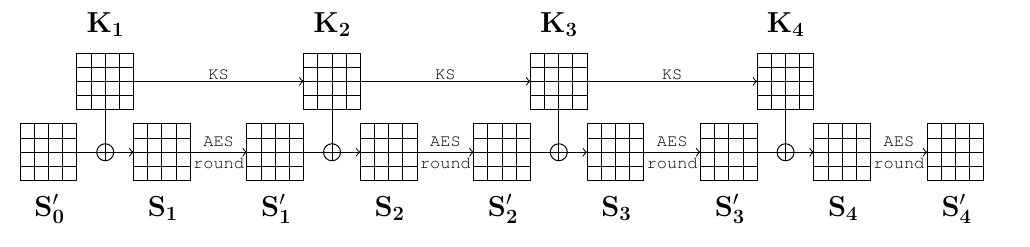
Figure 2: Notations for 4 rounds of AES-128